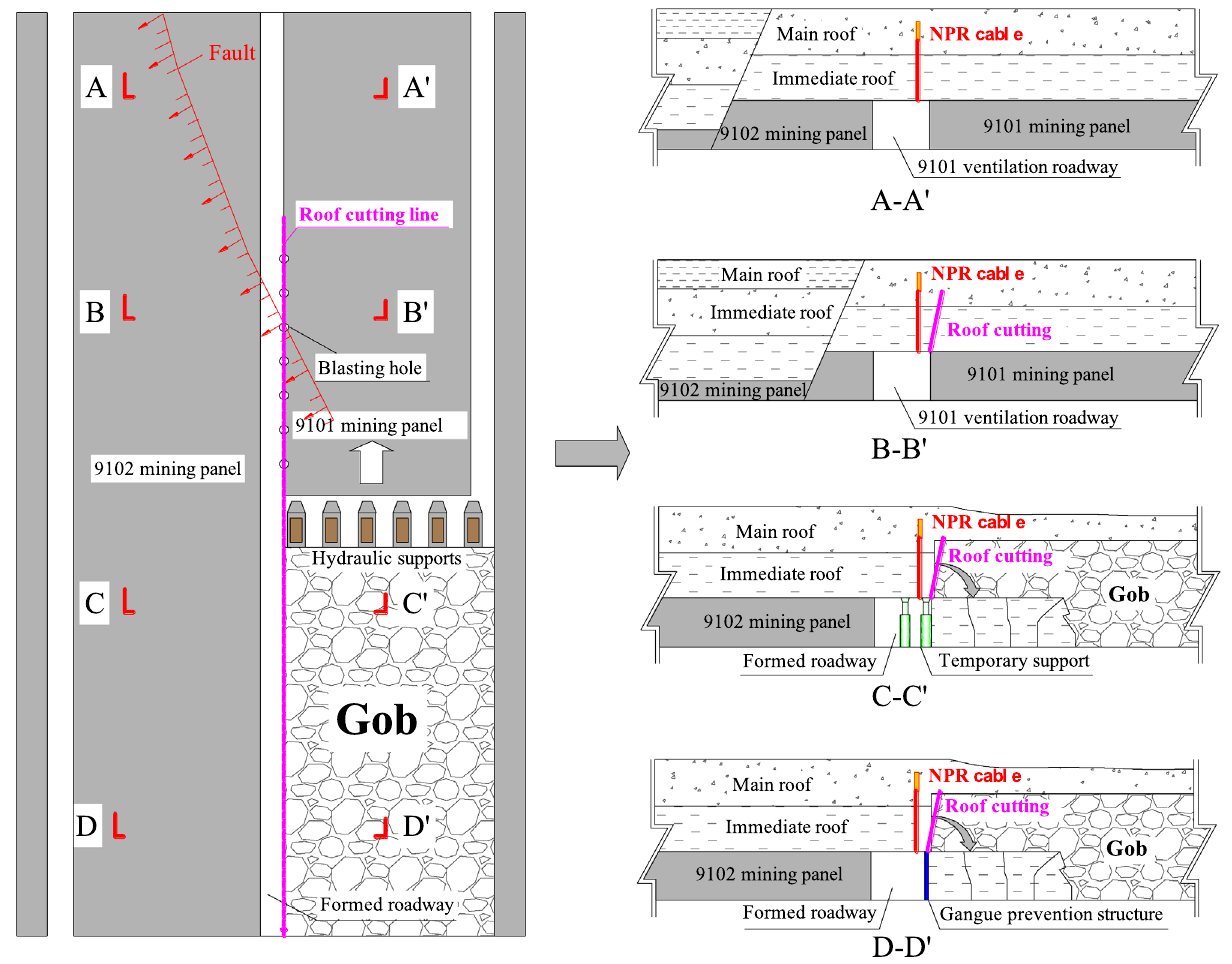
Figure 5. Experimental process of the ARFRC method in the 9101 ventilation